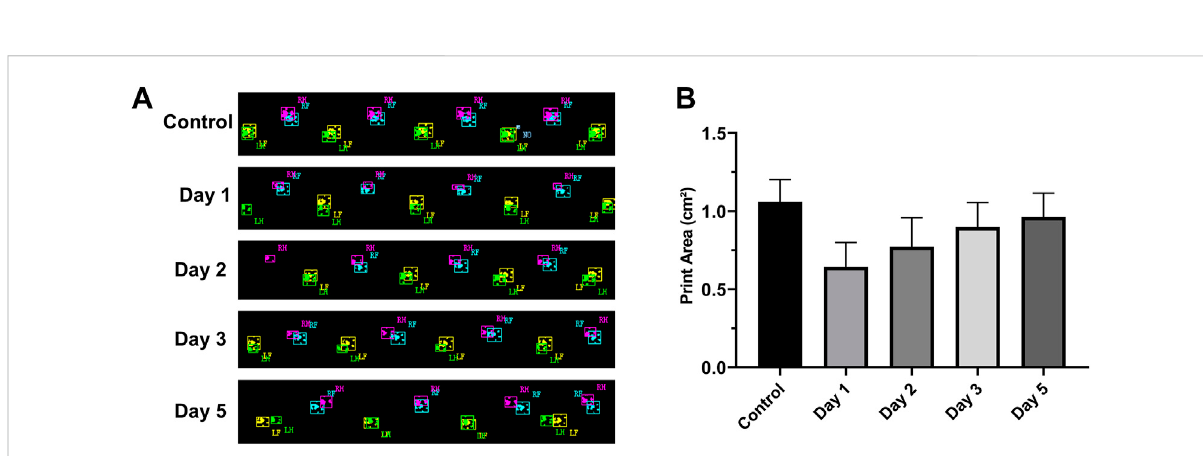
FIGURE 5 RH footprints atdifferenttimes and their change trend ( n = 10,RF= right front, LF =left front, RH= righthind, and LH= left hind). (A) Footprints at different time points. (B) Footprint area – time line chart. The footprint area of rats decreased signi fi cantly on the fi rst day after the injury and then increased slowly on the next few